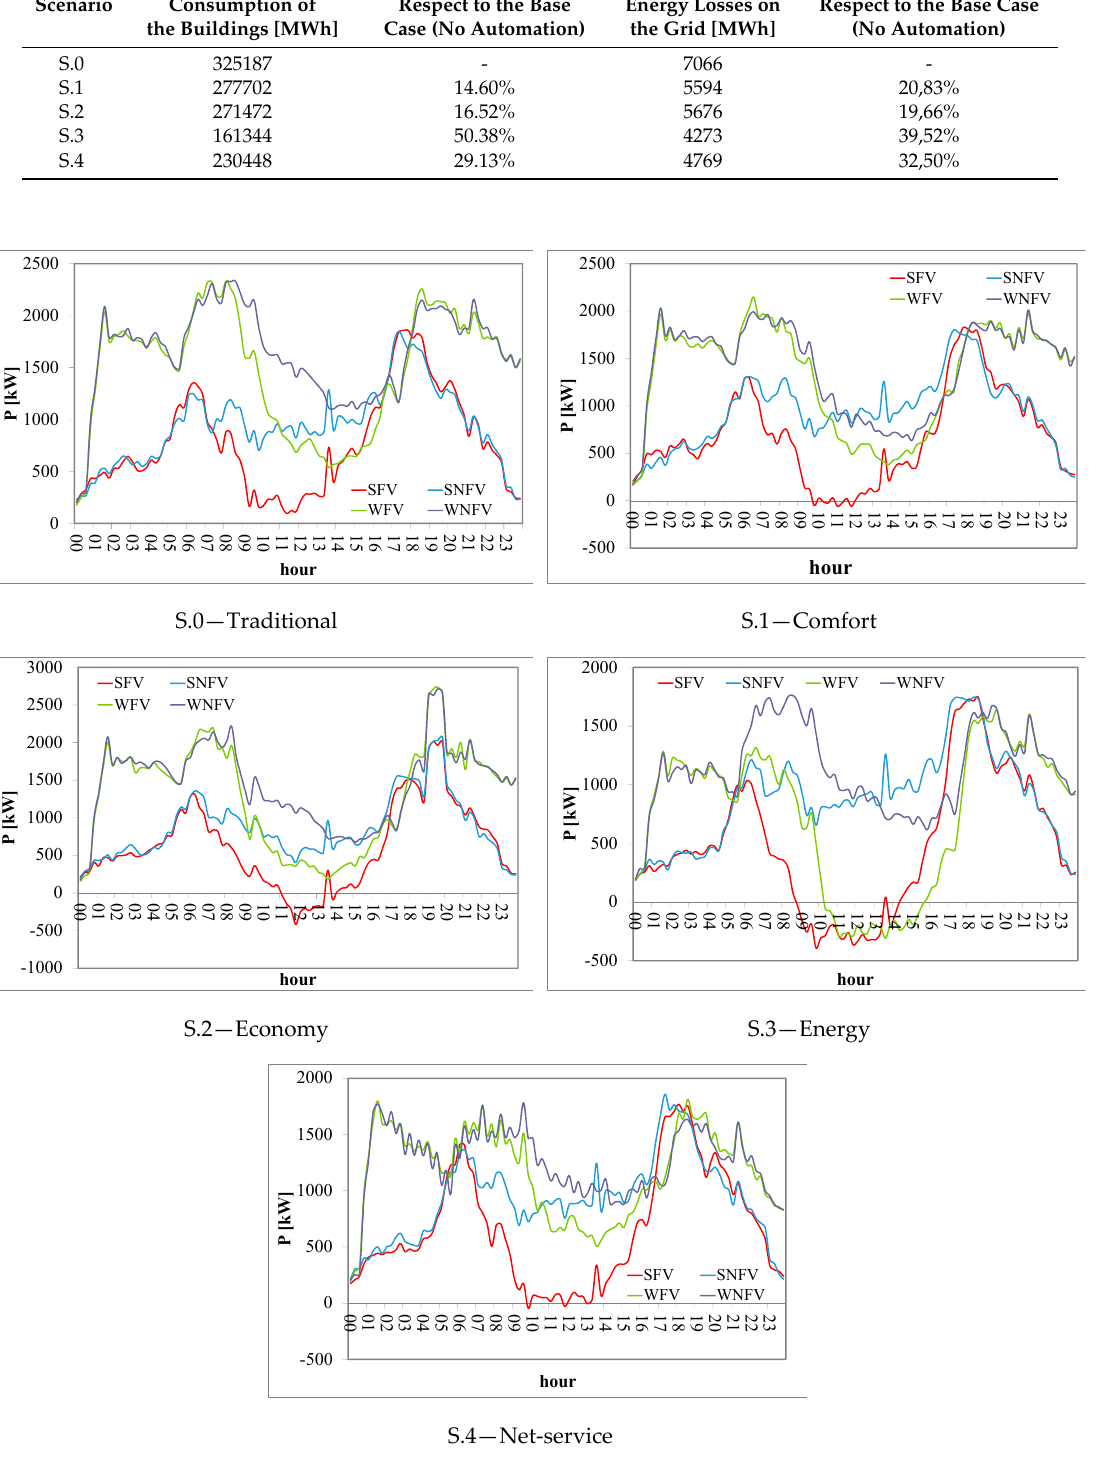
Figure 4. Rome: daily power profile at a primary substation for Scenarios S.0 to S.4.